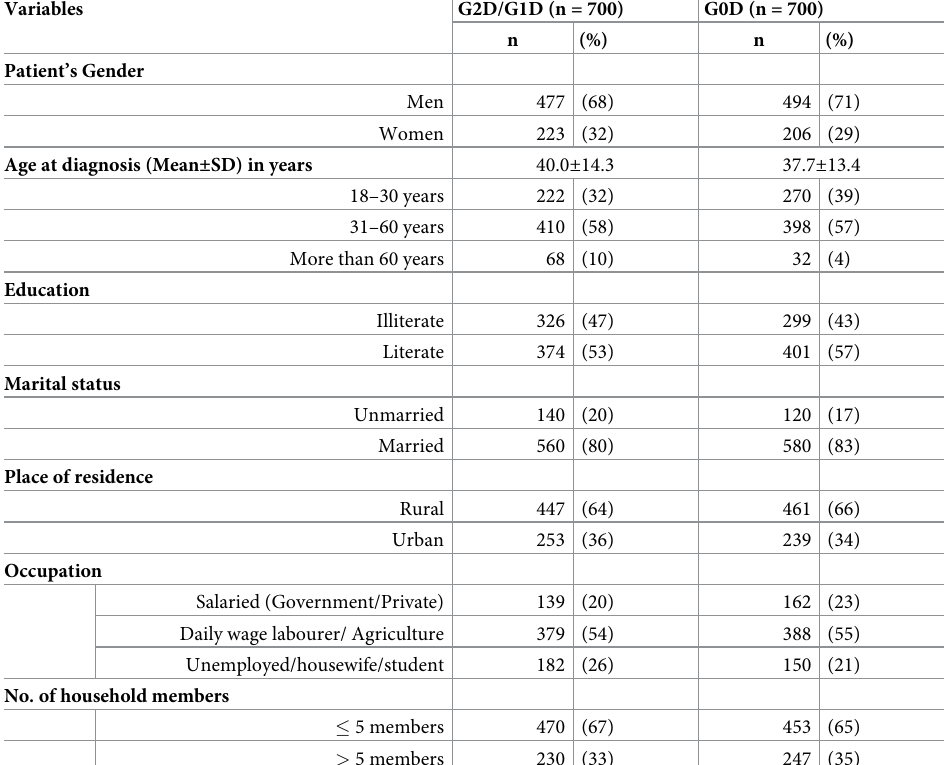
Table 1. General characteristics of G2D/G1D (cases) and G0D (controls) studied in the 5 states of India during 2014–2016.